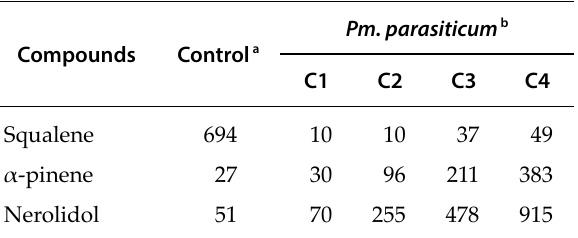
Table 2. Relative quantities of squalene, α-pinene and ne - rolidol calculated respect to a known amount of n- hexa- decane (ng mg -1 ) by GC-MS, in samples of calluses non inoculated (control) and inoculated with different concen - trations of Pm. parasiticum .